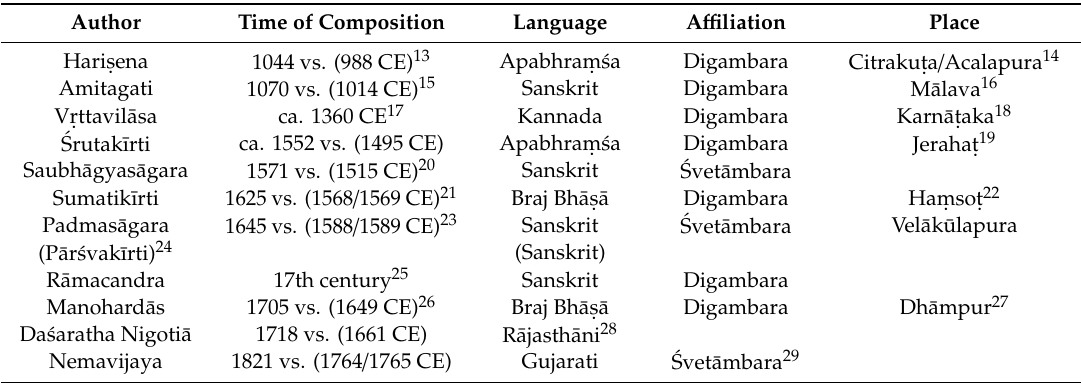
Table 1. Authors of a Dharmapar¯ıks. ¯a